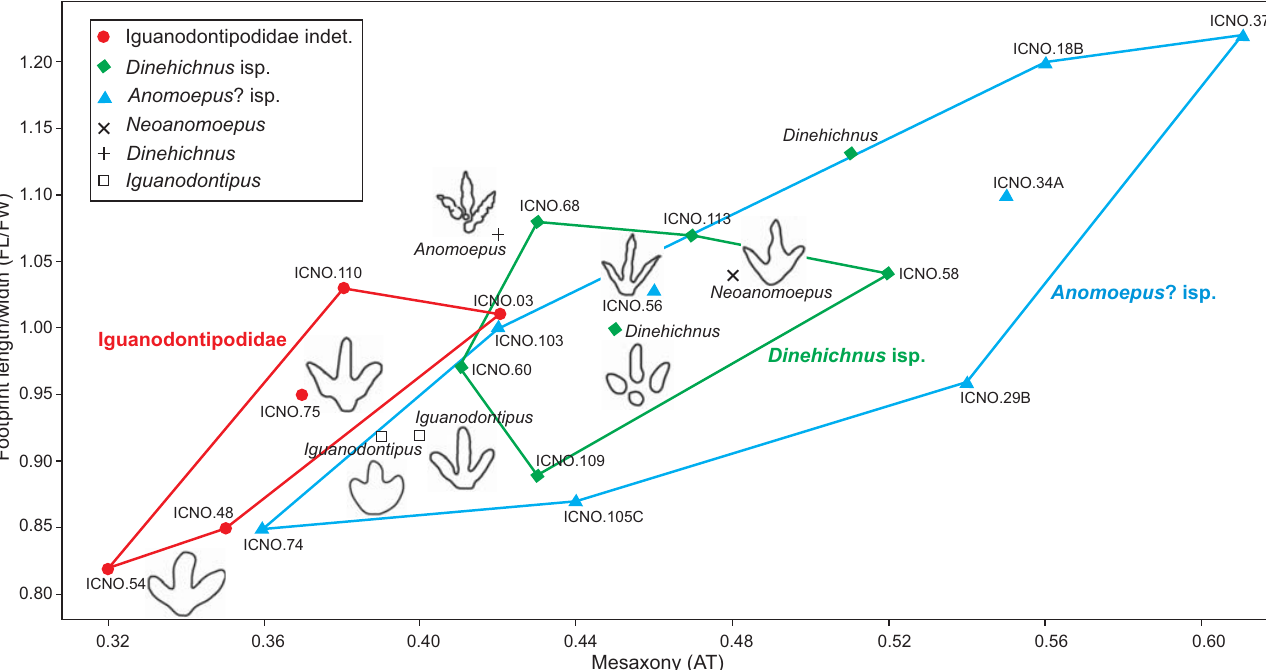
Fig. 8. Bivariate graph plotting the footprint length/footprint width ratio against the mesaxony (AT) of the studied tracks (bolded) compared with the ichnotaxa Anomoepus , Neoanomoepus , Dinehichnus , and Iguanodontipus (data from Lockley 2009) . Outline drawings not to scale. For simplicity the acronym ICNO.# was used instead of